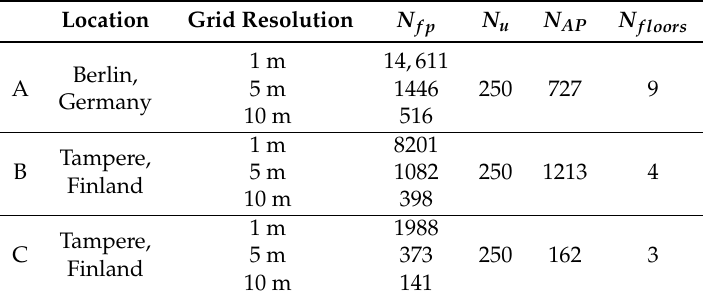
Figure 1. The grid of collected measurements for building A. Fixed grid resolution of 1 m × 1 m. Table 1. Measurement scenarios. N fp corresponds to the number of fingerprints with fixed grid resolution in the